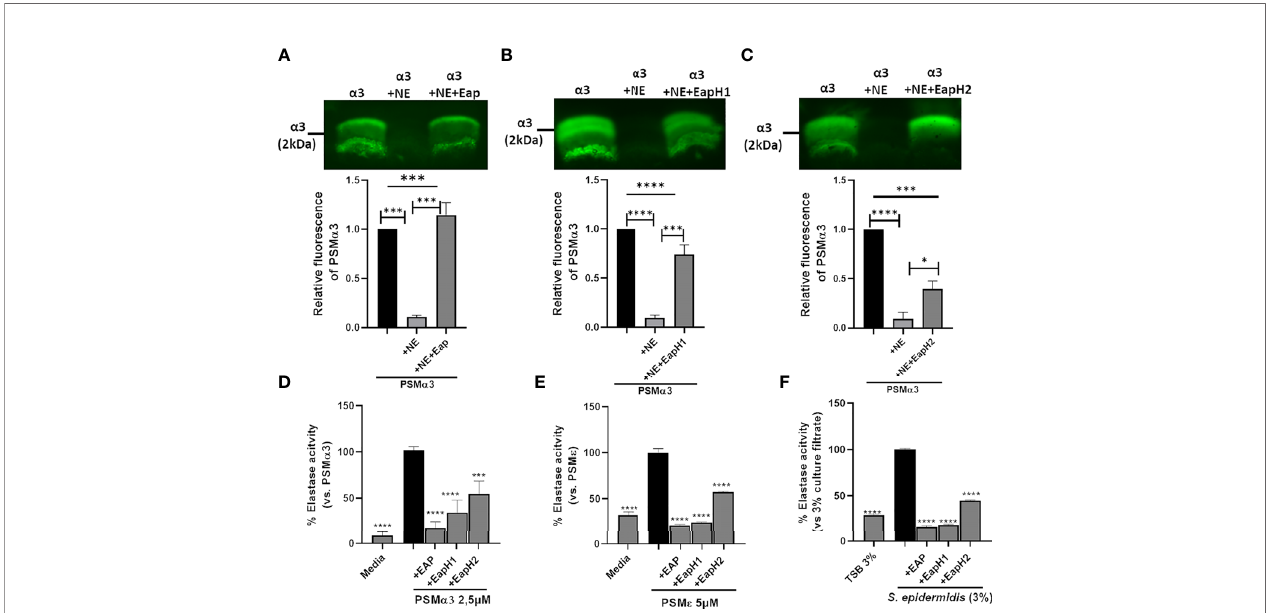
FIGURE 4 | S. aureus -derived NSP inhibitors prevent degradation of PSM a 3. Western blot of PSM a 3 after incubation with NE alone (0.15 U) or with 2 µg/ml Eap (A) , EapH1 (4 µg/ml) (B) or EapH2 (4 µg/ml) (C) . NE activity of neutrophils +/-preincubation with Eap, EapH1 or EapH2 after stimulation with PSM a 3 (D) , PSM e (E) . NE activity of neutrophils incubated with S. epidermidis culture fi ltrates (3%) +/- recombinant Eap, EapH1 or EapH2 (each 5µg/ml). Data represent one experiment out of three (A – C) and mean +/-SEM of three independent experiments (A – D) . *P < 0.05; ***P < 0.001; ****P < 0.0001 signi fi cant difference versus NE-treated PSM a 3 (A – C) , the PSM a 3- (D) or PSM e -treated control (E) as well as the culture fi ltrate treated control (F) as calculated by one- way ANOVA with Dunnett ’ s multiple comparisons